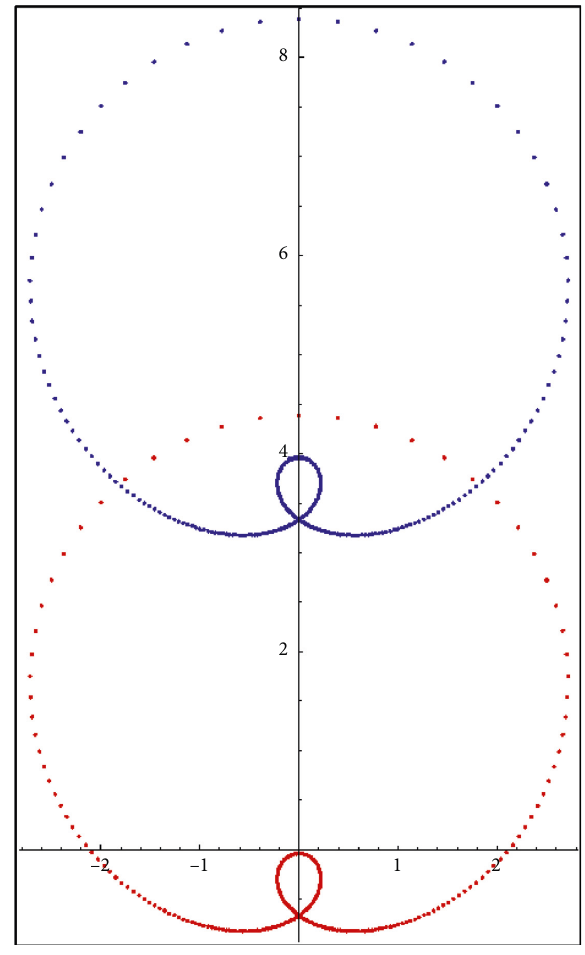
Figure 2: Graphs of h Example